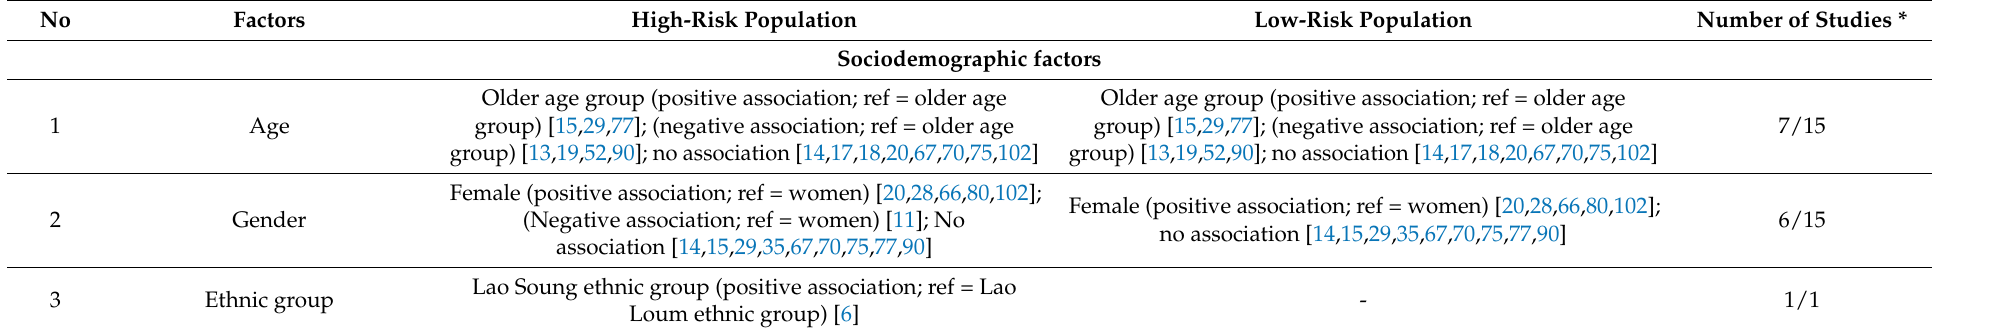
Table 4. The determinants of hepatitis B vaccine